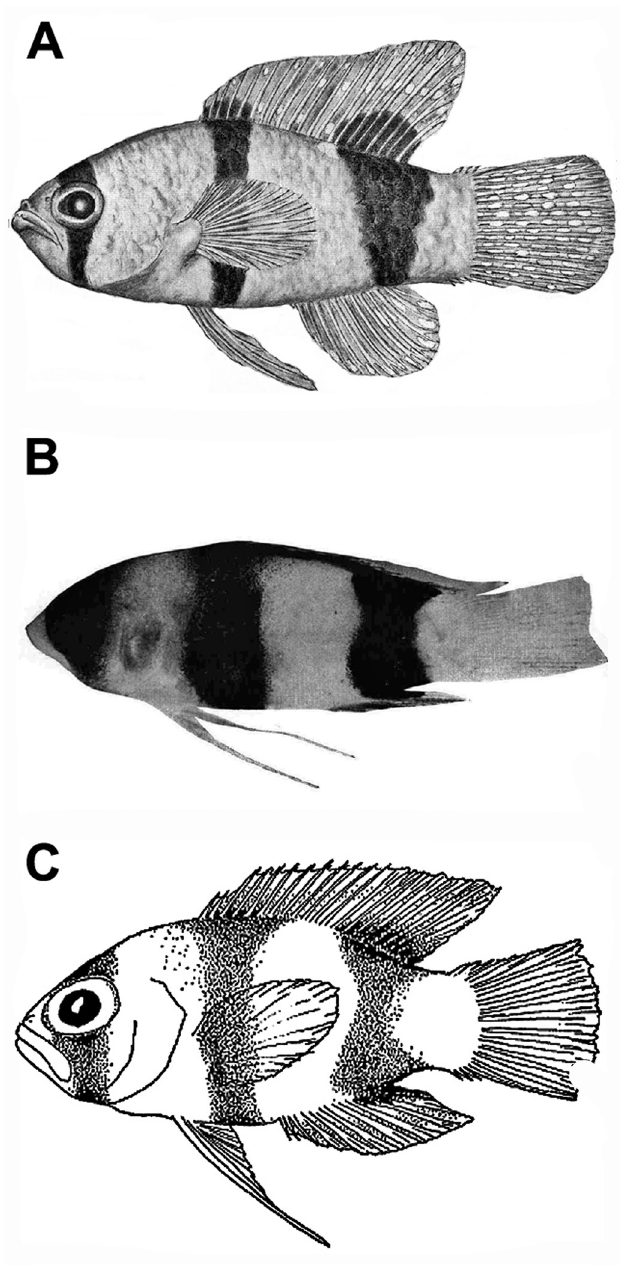
Figure 1. Previously published images of A Lipogramma evides, 34.4 mm SL, ANSP 134329, holotype, from Robins and Colin (1979: fig. 1) B Lipogramma levinsoni sp. n., 12.6 mm SL, ANSP 134332, as juvenile paratype of L. evides in Robins and Colin (1979: fig. 2) C Lipogramma levinsoni sp. n., 14.1 mm SL, IRCZM 107: 07660, as juvenile of L. evides in Gilmore and Jones (1988: fig. 3). Images reproduced with permission from Bulletin of Marine